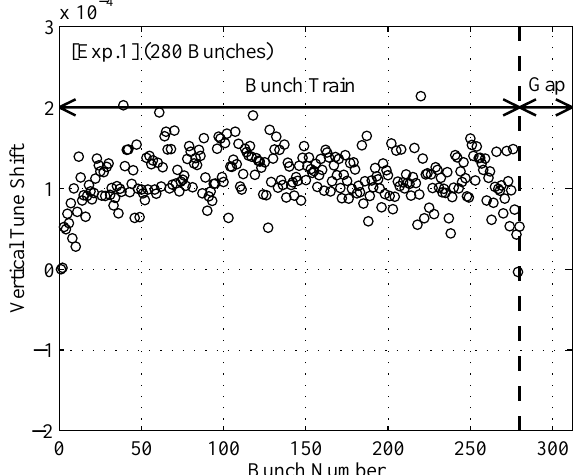
FIG. 5. Vertical tune shifts of individual bunches along the bunch train with 100 bunches.